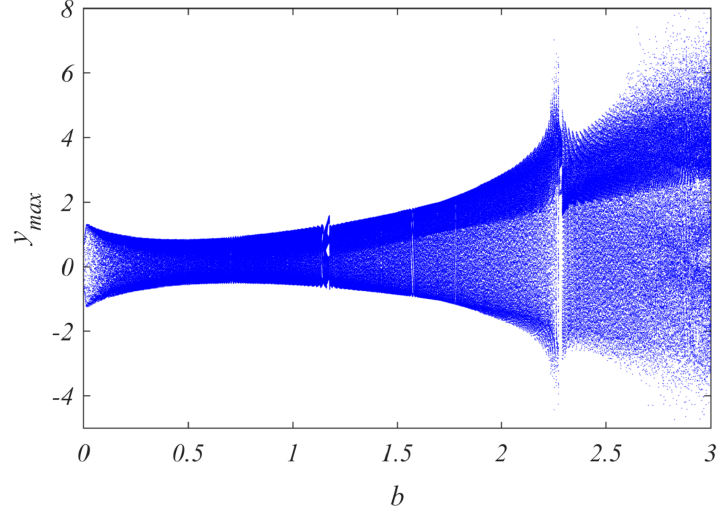
Figure 3. The bifurcation diagram verse system parameter ( b ).